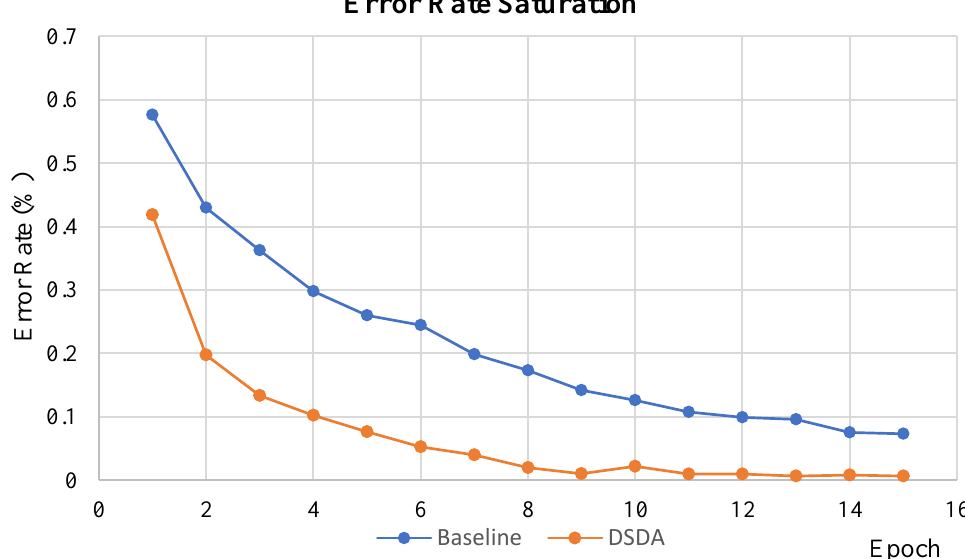
Figure 8. Error rate saturation along the epoch on the training dataset. The blue curve shows the saturation of baseline [10] and the orange curve shows the saturation of the proposed DSDA.